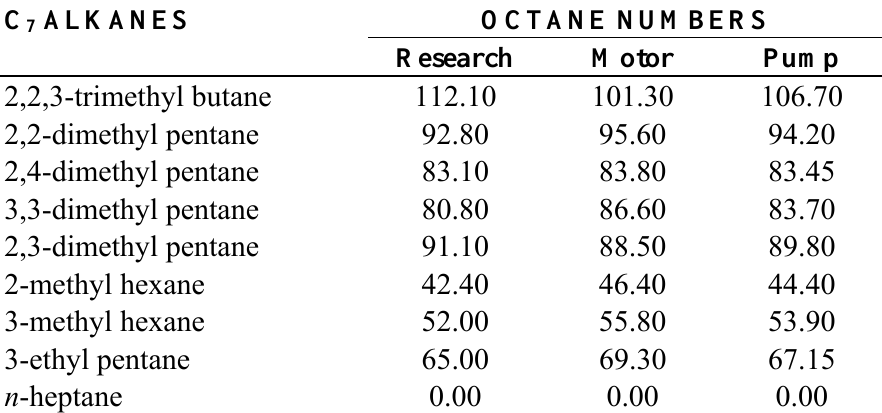
Table 2. Octane numbers of heptane